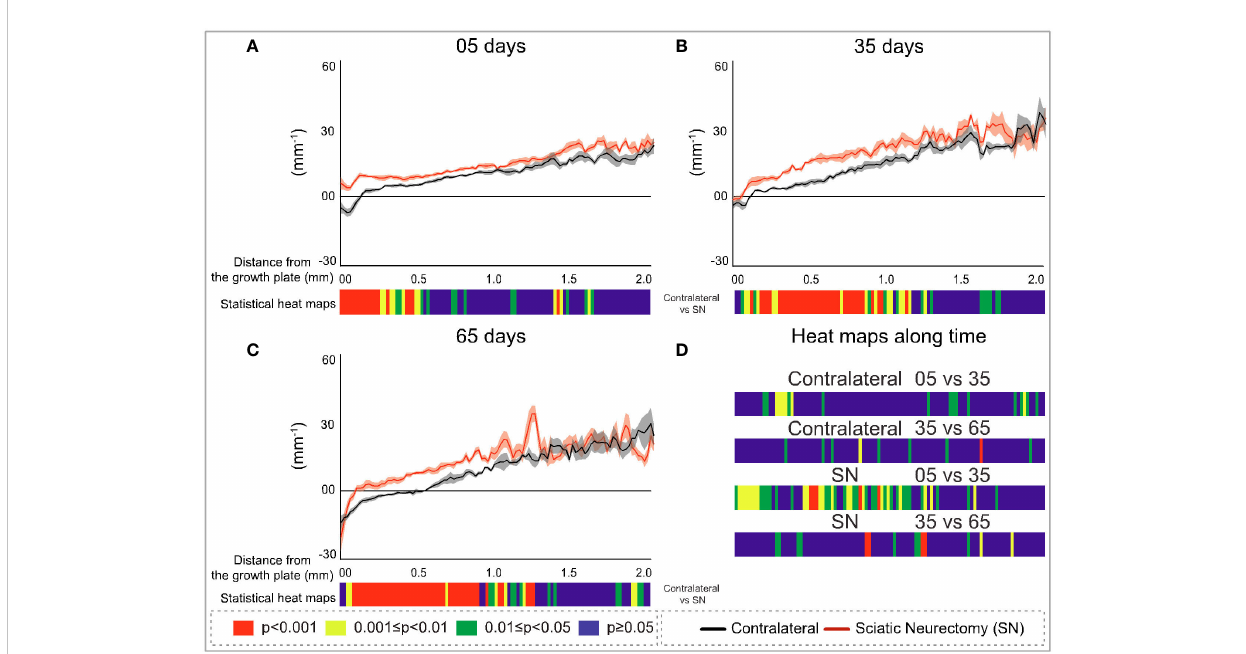
FIGURE 9 Cross-sectional (2D) trabecular bone pattern factor (Tb.Pf) with distance from the growth plate in study B in sciatic-neurectomised (SN, red) and contralateral tibias (black) at (A) 5 days, (B) 35 days, and (C) 65 days after surgery. For all pro fi les, the SEM ranges are shown graphically. In each of the three charts, the colour bar below shows the p -value of the signi fi cance of difference (chi-square) by cross-sectional plane (downstream distance) between the left contralateral and right SN tibias. Additional colour bars (D) show if changes occurred earlier or later in the study based on the signi fi cance of difference of the cross-sectional Tb.Pf with downstream distance in time-based comparisons spanning early and late time intervals for SN and contralateral control limbs.